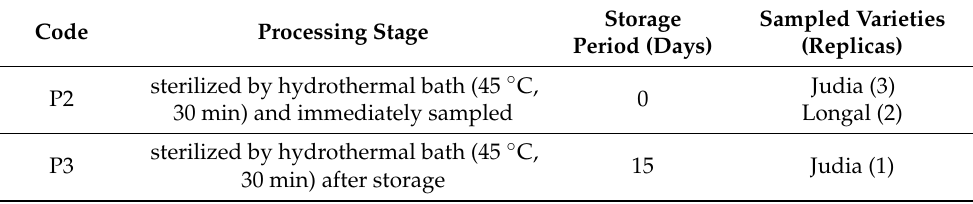
Table 1. Description of chestnuts sampling points, storage period and sampled varieties. Code Processing